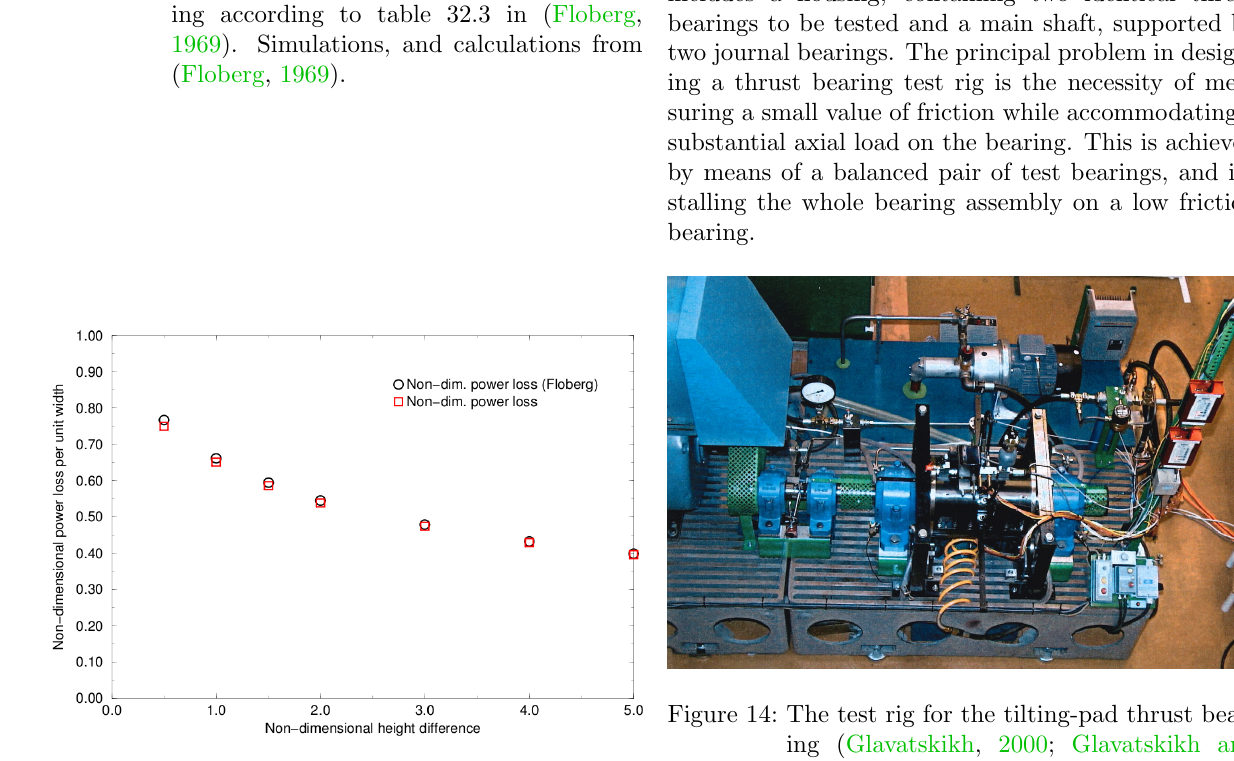
Figure 13: Non-dimensional power loss per unit width for sector-shaped tilting pad thrust bear- ing according to table 32.3 in (Floberg, 1969). Simulations, and calculations from (Floberg, 1969).